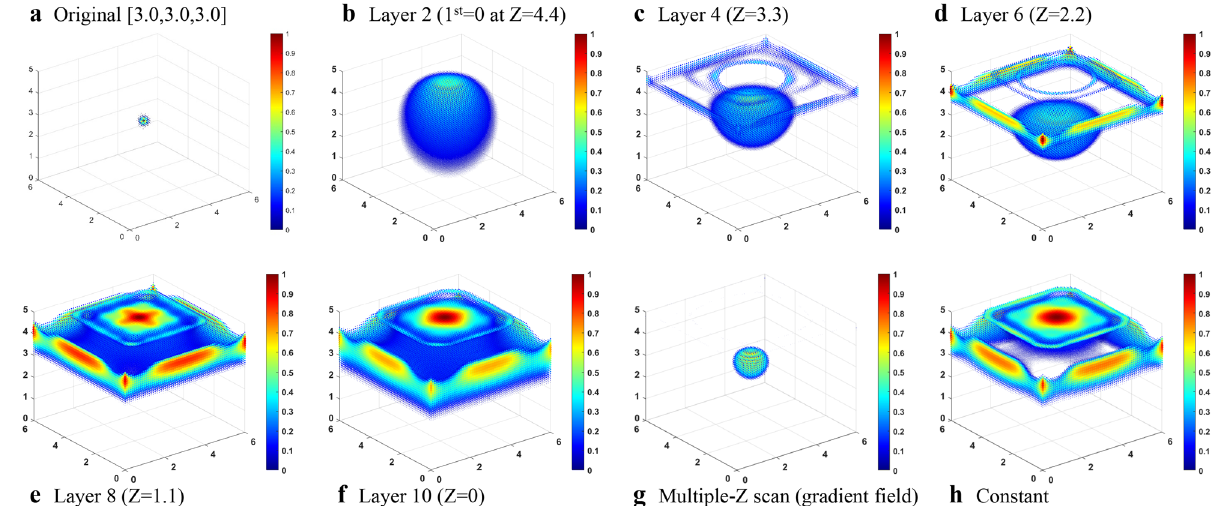
Figure 4. ( a ) Original distribution. Inverse distribution with the gradient field that made the lead field matrix to have local maximum at different layers: ( b ) layer 2 ( Z = 4.4 cm), ( c ) layer 4 ( Z = 3.3 cm), ( d ) layer 6 ( Z = 2.2 cm), ( e ) layer 8 ( Z = 1.1 cm), and ( f ) layer 10 ( Z = 0 cm). ( g ) Ten-layer multiple Z scan (gradient field) and ( h ) constant